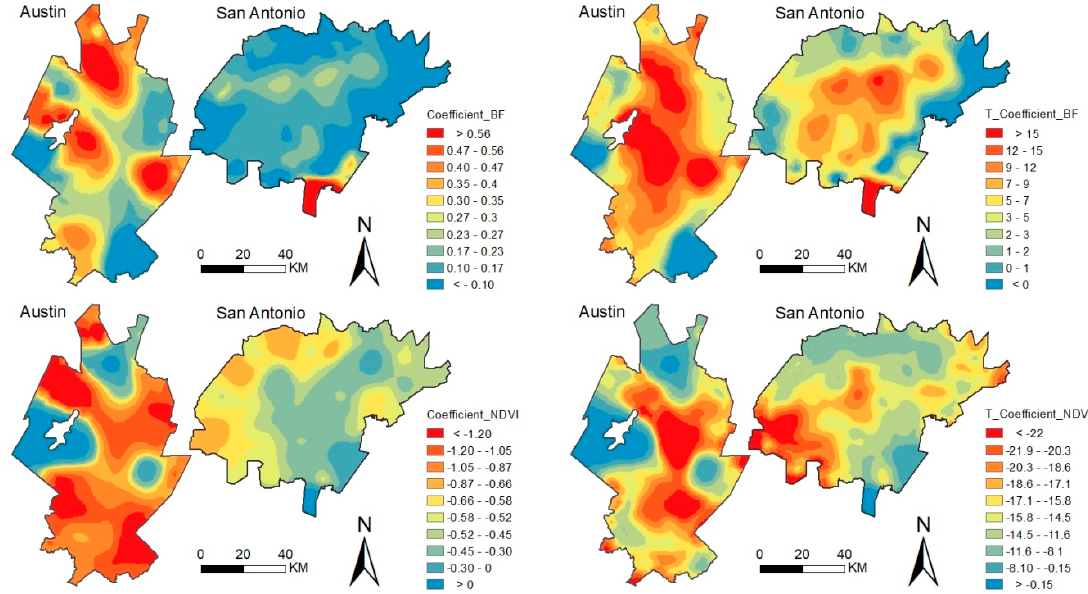
Figure 5. Overall spatial variation of the coefficients ( left ) and the t statistics ( right ): Buildings Fraction (BF) and NDVI.